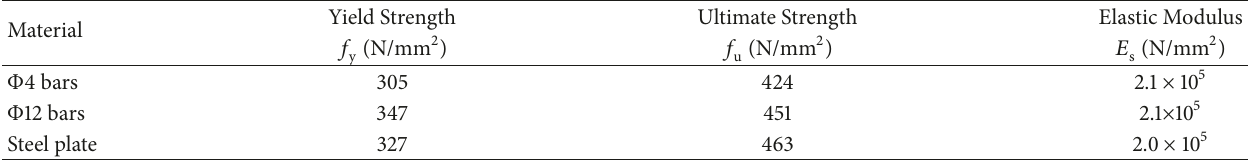
Figure 4: Composite slab system (units: mm). Table 2: Materials properties of